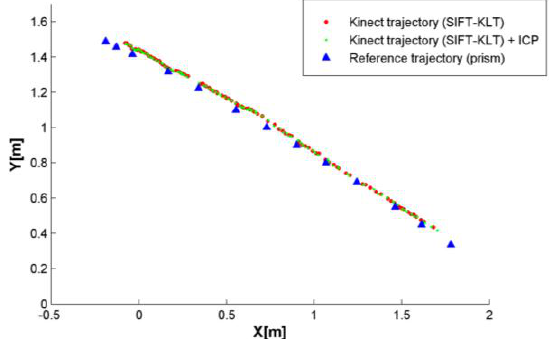
Figure 6. Trajectories estimated with the Kinect using the proposed integrated solutions X[m] RMSe KLT-SIFT Kinect 2.0